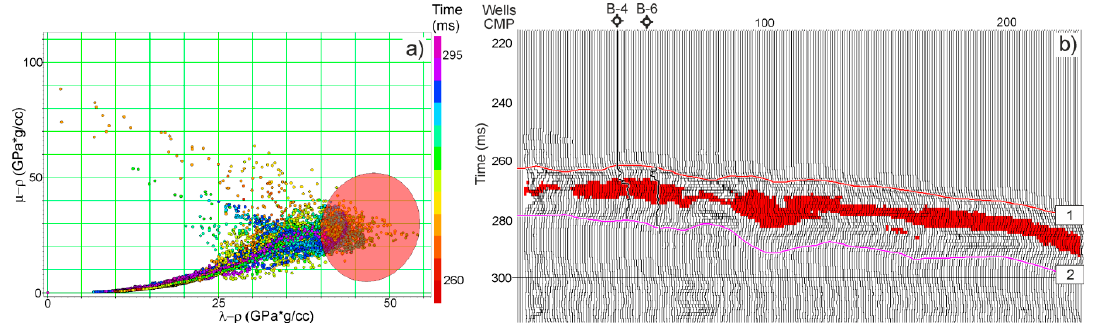
Figure 13. ( a ) The crossplot of λ - ρ versus μ - ρ attributes derived from P- and S-impedance values for evaporitic formation; ( b ) Projection of points from a polygon in cross-section display highlights areas where limestone is very stiff and is characterized by high sulfur content. Horizons 1 and 2 are, respectively, the top and bottom of the evaporitic formation. Well logs indicate sulfur content (%).